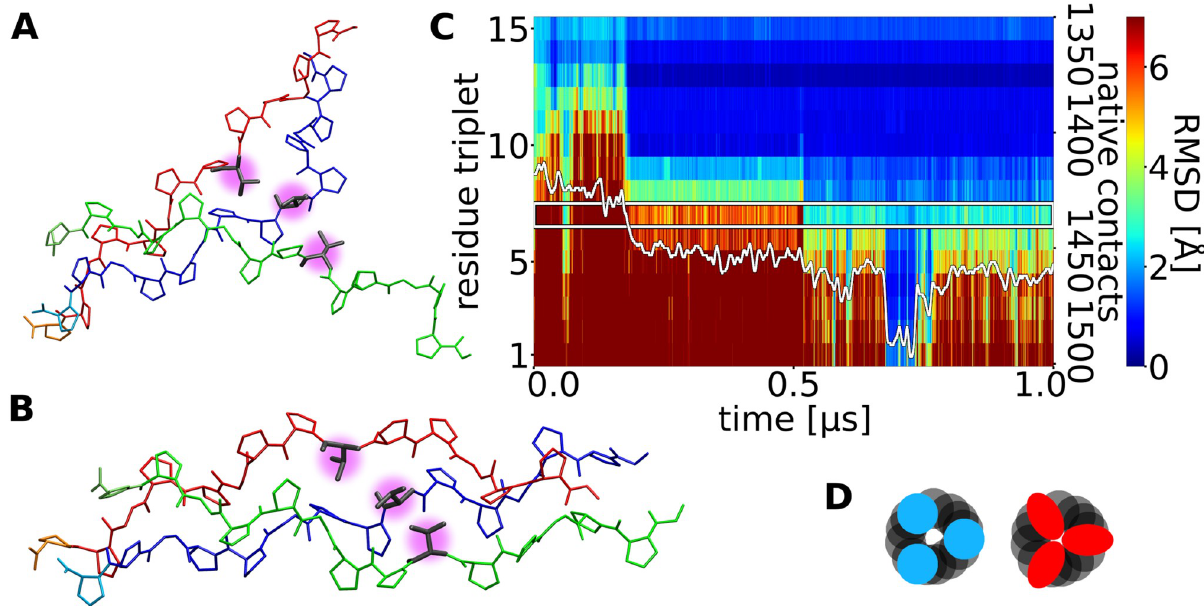
Fig 9. Residue substitutions can strongly affect triple helix folding. (A) Snapshot of an intermediate state with the triple helix formed up to the center of the chains that each contain a central G ! T substitution (magenta sphere). (B) Short-lived sampled snapshot of the same chains, temporarily folded to a triple helical conformation, but the middle part around the mutations adopting an expanded structure. (C) RMSD plot of residue triplets along the triple helix (one residue of each chain per triplet) and native contacts. The blue part of the plot indicates correctly folded triple helix, at ~0.7 μ s the complete near-native folded triple helix is observed but unfolds again at ~0.78 μ s. (D) schematic cross section of helices at the position of the mutations to illustrate how the mutated residues (red) sterically collide with the other chains, compared to the WT helix